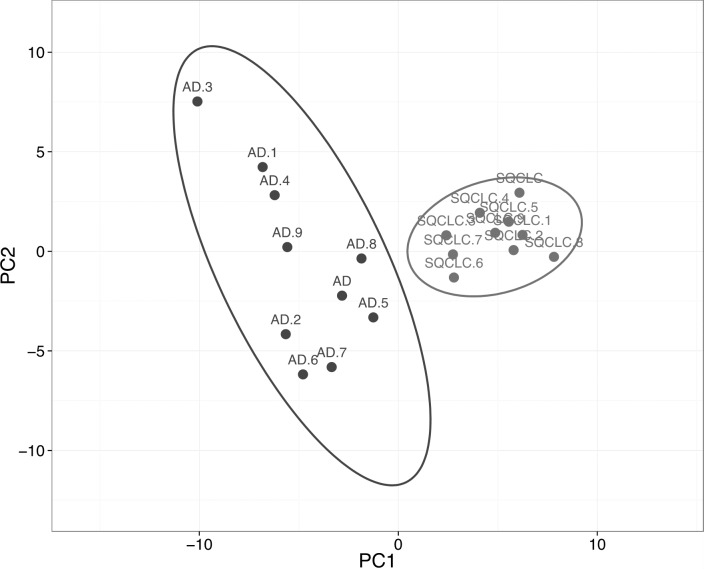
Expression of 106 HKGs is a significant class predictor for subsets of non-small cell lung cancers.Ten samples each of AD and SQCLC were randomly selected as testing set, which were able to be distinguished by 106 differentially expressed HKGs. AD, Adenocarcinoma; SQCLC, Squamous Cell Carcinoma.